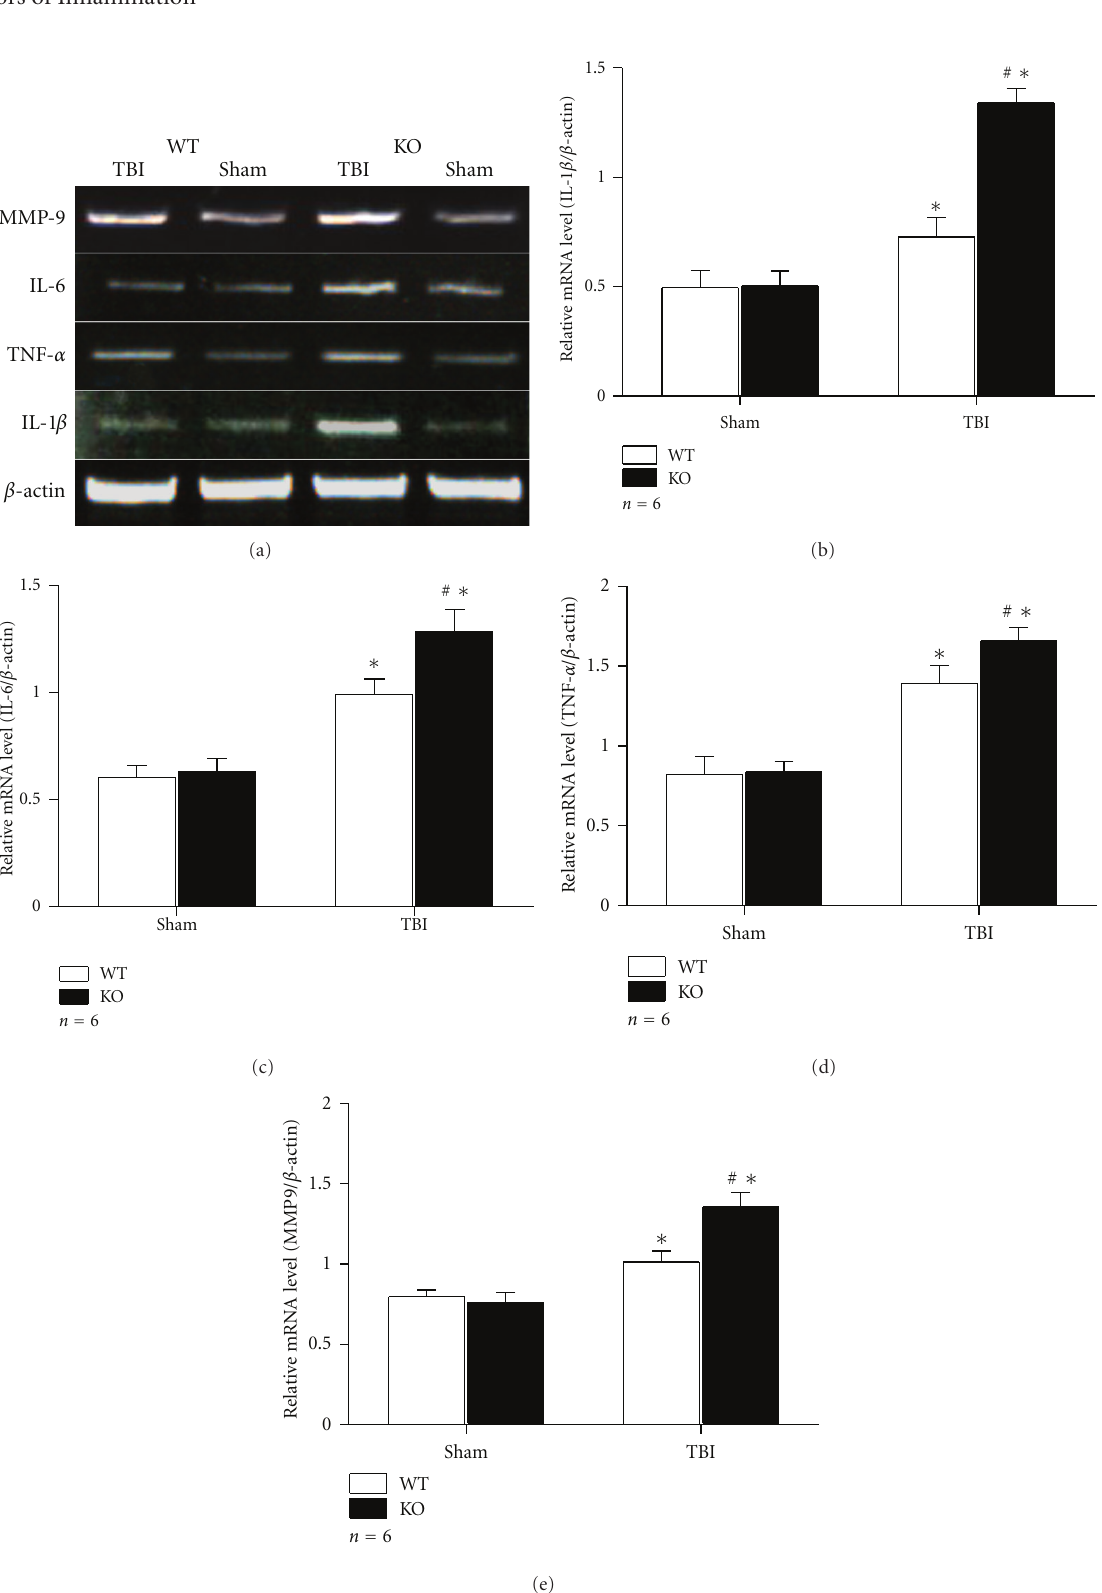
Figure 3: RT-PCR analysis of mRNA level of proinflammatory cytokines and MMP9. (a) RT-PCR showed that mRNA level of TNF- α , IL- 1 β , IL-6, and MMP9 was elevated in astrocytes after scratch and was significantly higher in group KO TBI than in group WT TBI. (b–e) Quantitative analysis of RT-PCR results showed that relative mRNA level of proinflammatory cytokines mentioned above and MMP9 was higher in astrocytes after scratch ( P < 0 . 01). Such elevation was more severe in group KO TBI than in group WT TBI ( P < 0 . 01). ( ∗ P < 0 . 01, compared with sham counterpart; # P < 0 . 01, compared with WT